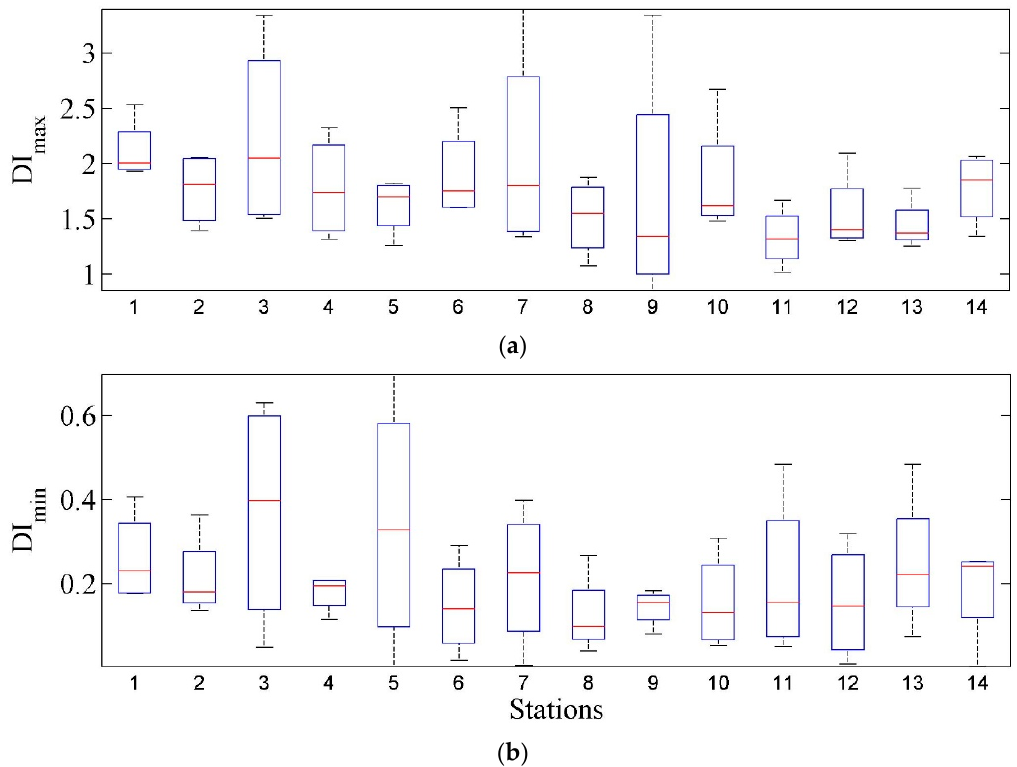
Figure 6. Distribution of extremes of DIs in mm/month across the FS and NW provinces. ( a ) Maximum distribution of DIs across the FS and NW, ( b ) minimum distribution of Dis across the FS and NW provinces